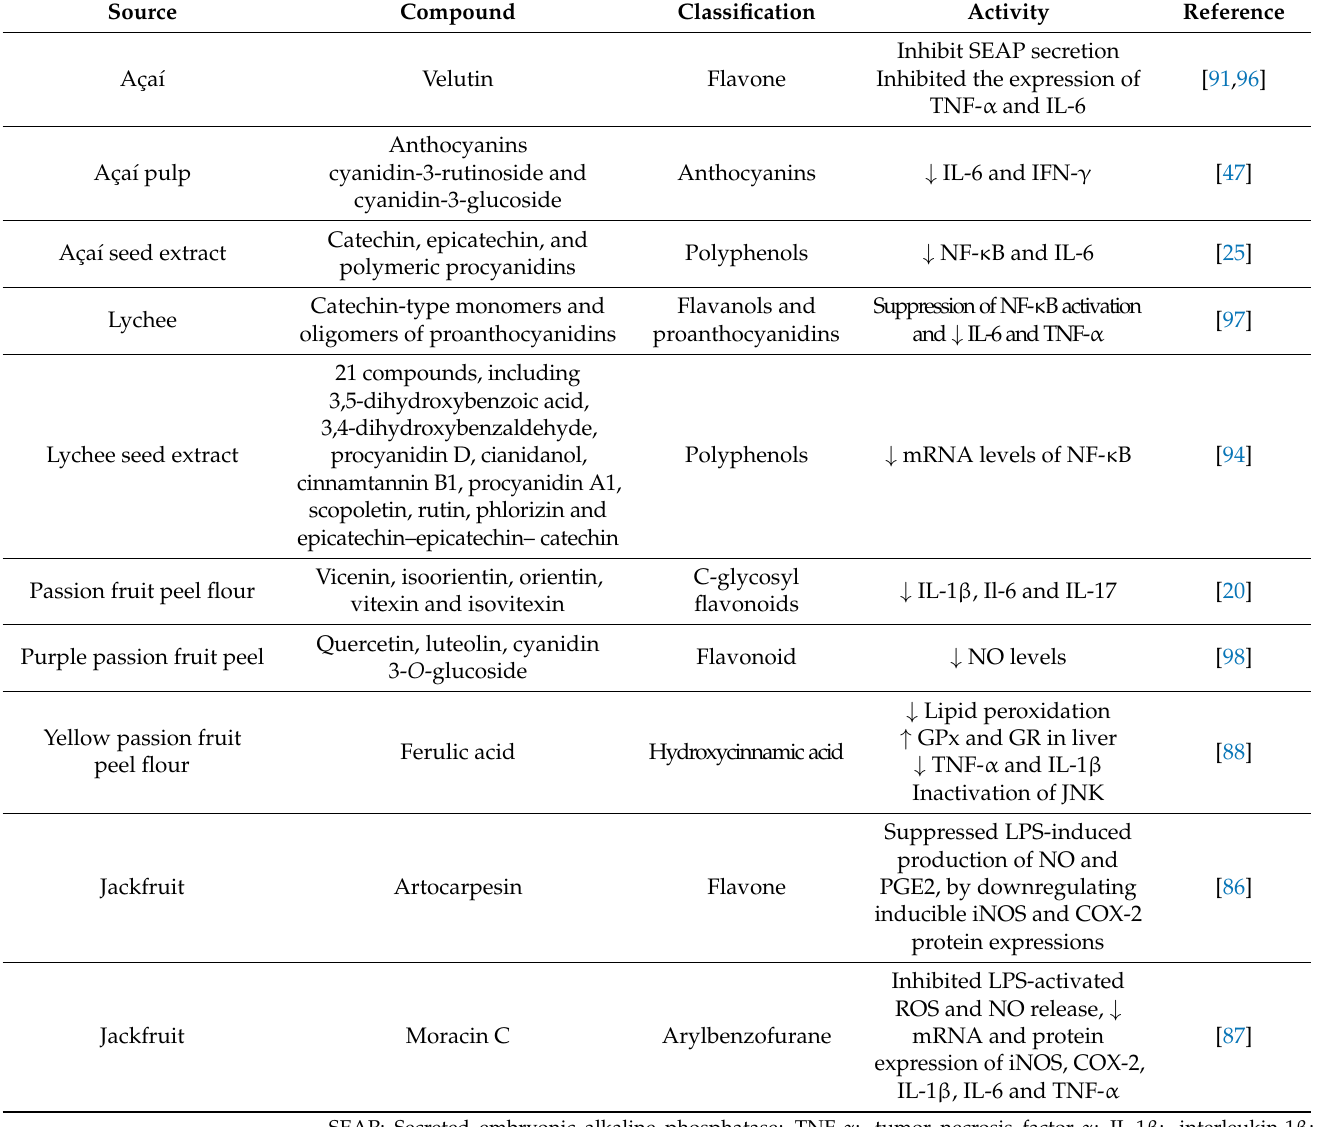
Table 4. Bioactive compounds from mamey, aça í , passion fruit, lychee, jackfruit, and their anti- inflammatory